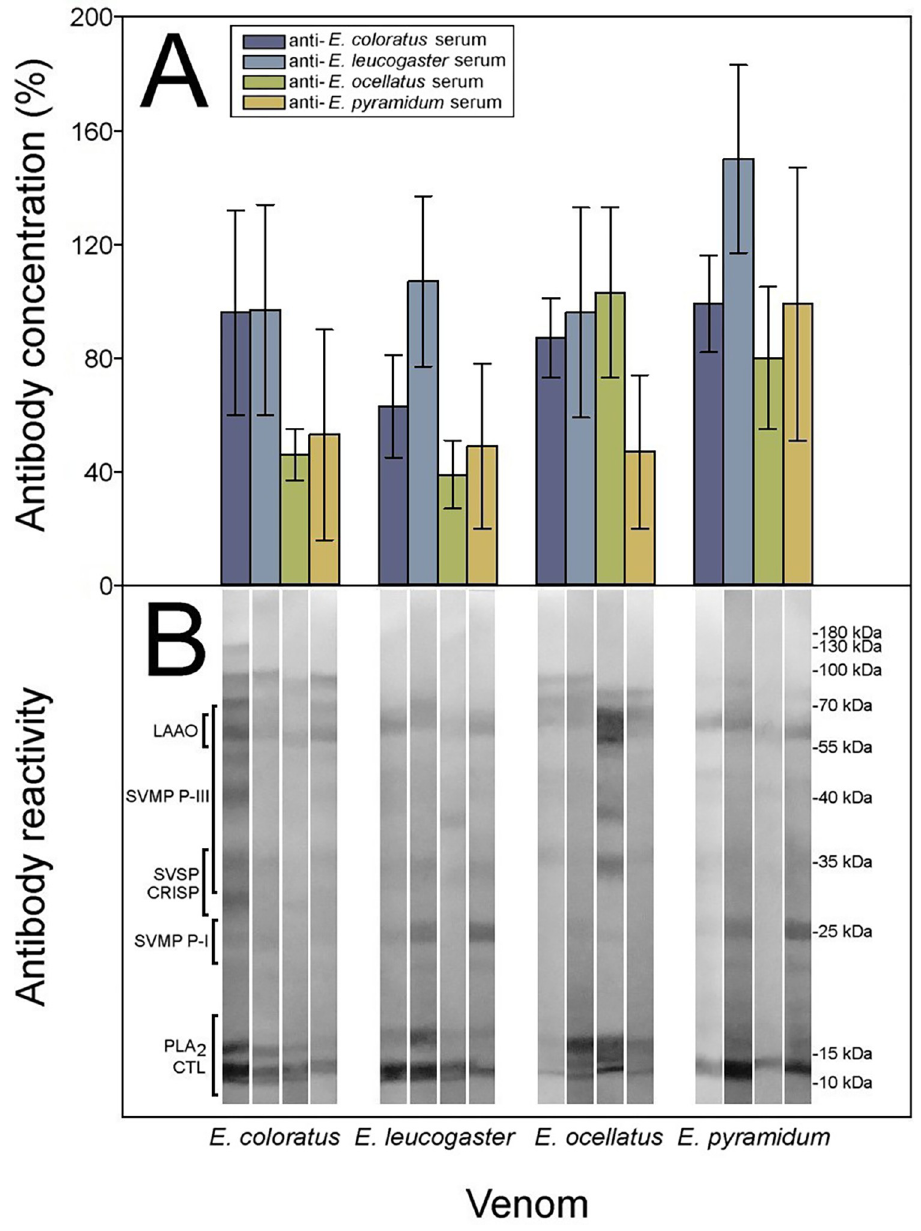
Fig 6. Immunochemical cross-reactivity between anti- Echis spp. sera. Cross-reactivity between anti- Echis spp. monospecific antisera and Echis spp. venoms determined by A) ELISA and B) Western blot. ELISA results are expressed as a percentage, considering as 100% the titer of serum raised against the homologous venom of each species and correspond to the mean ± SD (n = 4). All heterologous antisera have > 33% content of specific antibodies of the corresponding homologous antiserum. LAAO: L-amino acid oxidases, SVMP: Zn 2+ -dependent snake venom metalloproteinases, SVSP: snake venom serine proteinases, CRISP: cysteine-rich secretory proteins, PLA 2 : phospholipases A 2 , CTL: C-type lectin-like proteins. E . ocellatus , the anti- E . ocellatus antiserum against the venoms of E . leucogaster and E . pyrami- dum , and the anti- E . coloratus antiserum against the venom of E . leucogaster . A similar trend was observed in the neutralization of hemorrhagic activity, where an exten- sive cross-neutralization was observed, although with variable ED